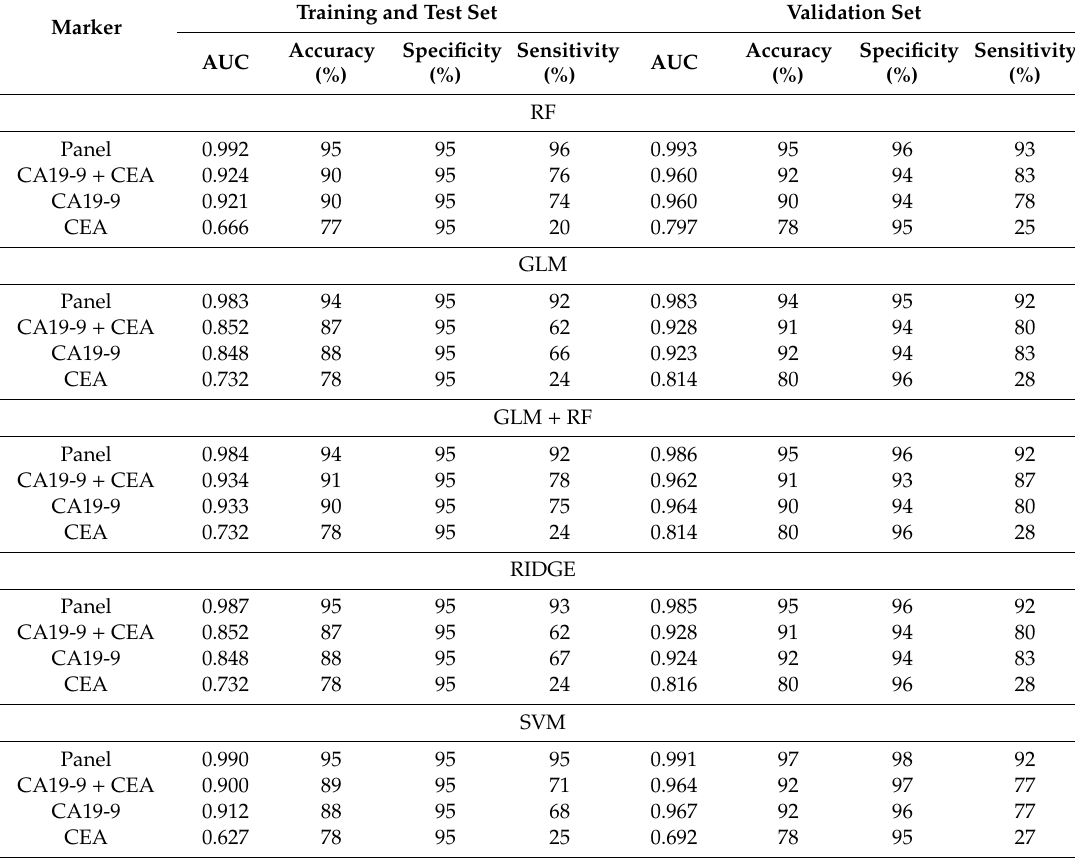
Table 2. Diagnostic performance of new biomarker